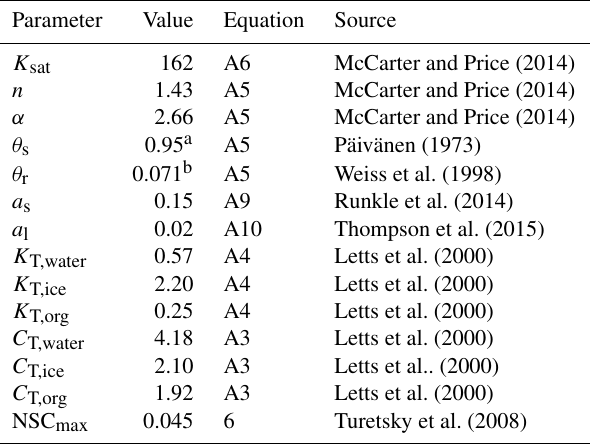
Table 2. Parameters values for the SVAT simulations (Module III). The parameters include the saturated hydraulic conductivity ( K sat ), the water retention parameters of water retention curves ( α and n ), the saturated water content ( θ s ), the permanent wilting point wa- ter content ( θ r ), the snow layer surface albedos ( a s , a l ), the thermal conductivity ( K T ), the specific heat ( C T ), and the maximal non- structural carbon (NSC) concentration (NSC max